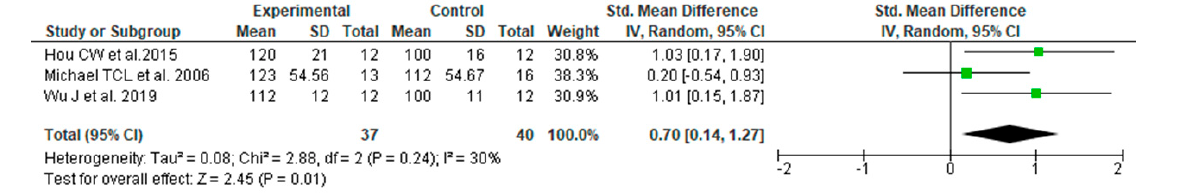
Figure 5. Forest plot for exercise endurance with ingestion Panax genus plants with ginsenoside compositions were standardized or analyzed [12–16].